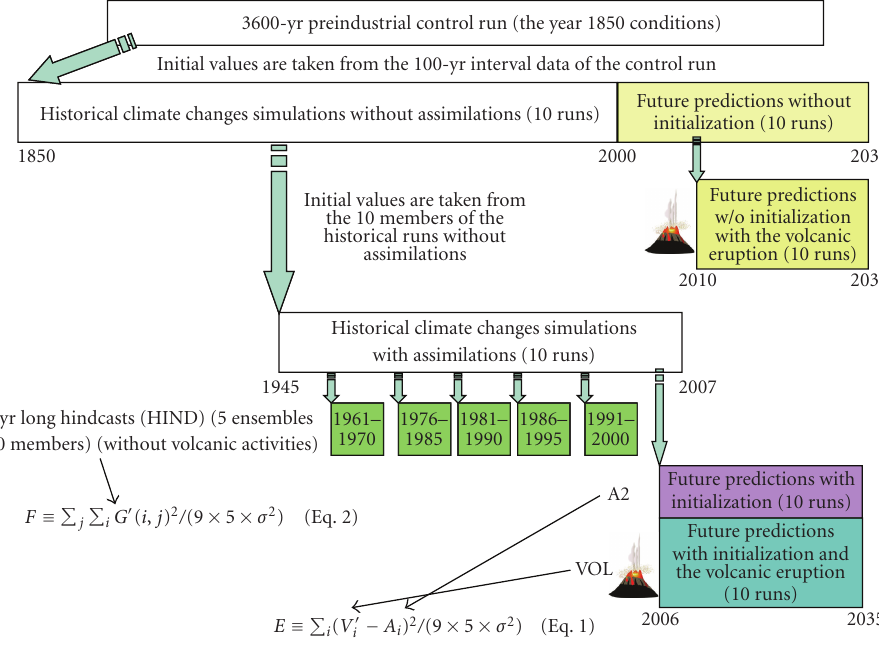
Figure 1: The experimental